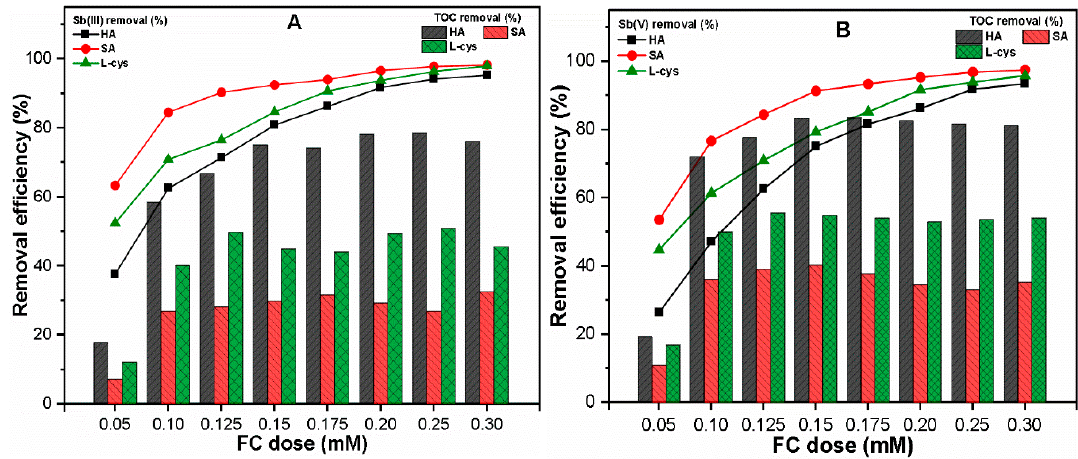
Figure 3. Removal efficiencies of ( A ) Sb(III); ( B ) Sb(V) and respective TOC from solution as a function of coagulant dose.